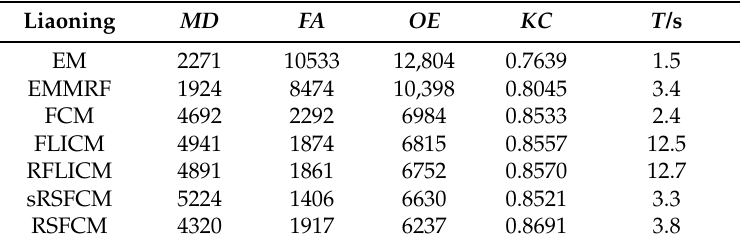
Table 4. Change detection results on Liaoning dataset.